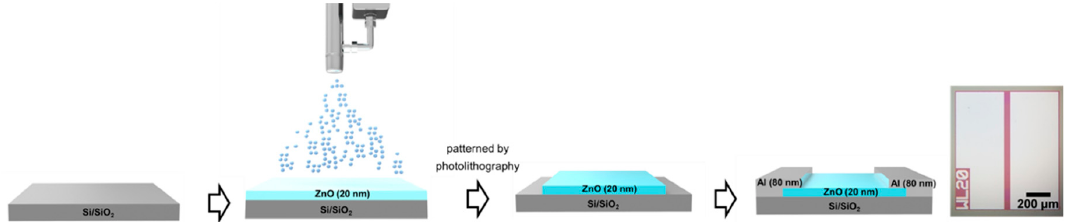
Figure 1. Fabrication procedure of ZnO field-effect transistors (FETs) by spray pyrolysis deposition and an optical image of the channel region. The ZnO (purple) channel layer and Al S / D electrode (light grey) were sequentially deposited on the Si / SiO 2 substrate (dark grey) via spray pyrolysis and thermal evaporation, respectively. The channel region was patterned by photolithography to minimize the leakage current.